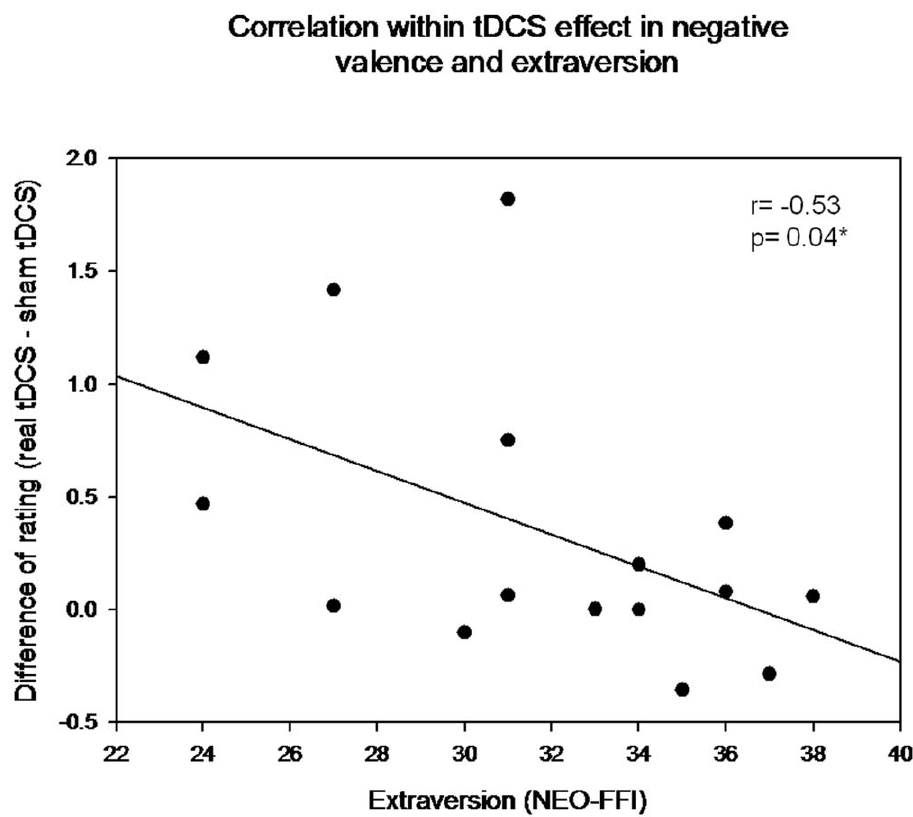
Figure 4. Modulation of personality measures on tDCS effects. The scatterplot depicts a negative correlation between increasing scores of the extraversion dimension of personality (represented in the x -coordinate) and the tDCS-induced effects (represented in the y -coordinate) evaluated by the mean change of rating in negative emotional pictures between real and sham tDCS. Note that the tDCS modulation is higher the more the subjects manifest themselves as introverts.